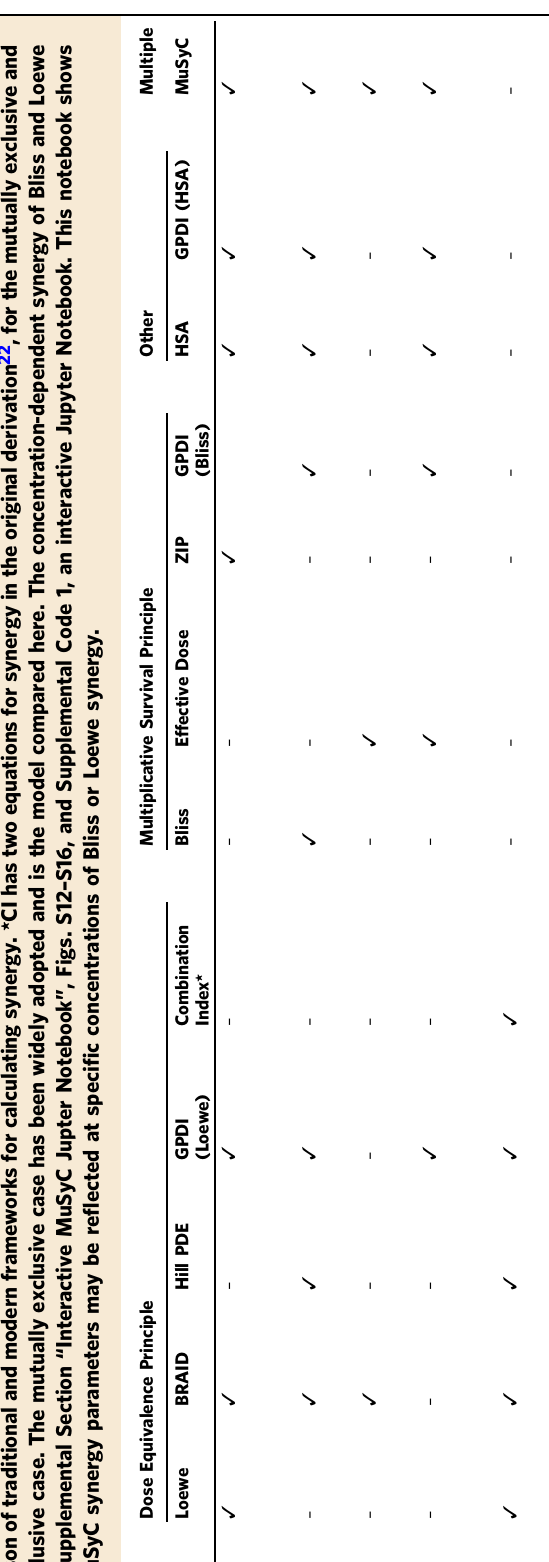
(Fig. 3B bottom distribution). As an example, the combination of methotrexate (targets folate synthesis) and erlotinib (EGFR inhibitor) in UWB1289 (BRCA1-mutant ovarian carcinoma) cells is antagonistically ef fi cacious and potent by MuSyC, but synergistic by Loewe (Fig.